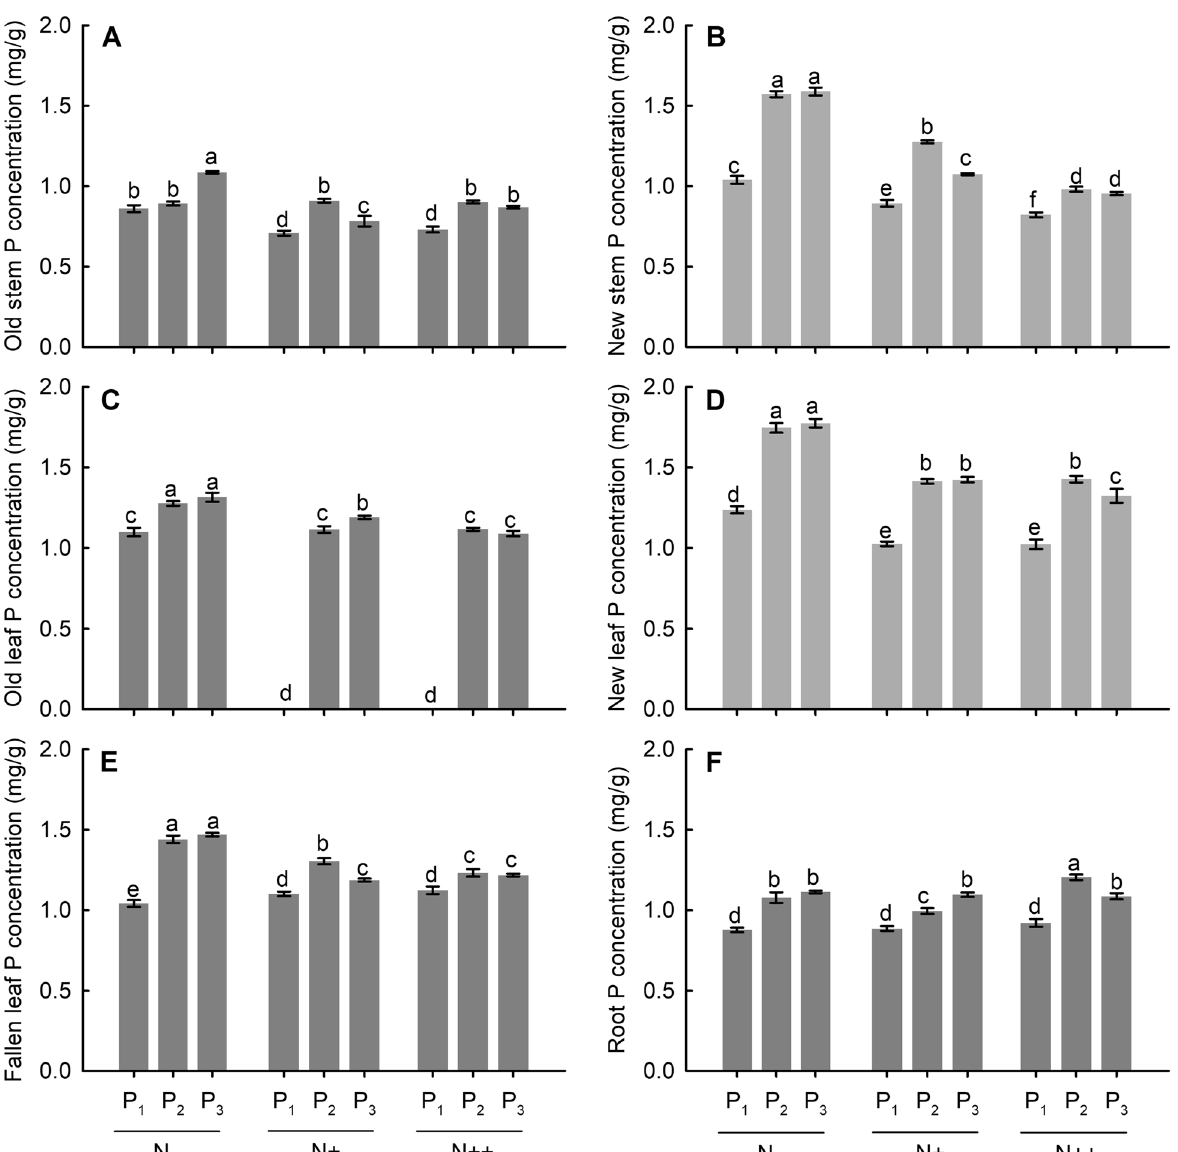
Fig. 1 P concentration of different component of P. edulis seedlings in response to experimental N deposition rate under different soil P availability. Different lowercase letters indicate significant differences among different treatments (Tukey’s HSD, α from the mean at each sampling (